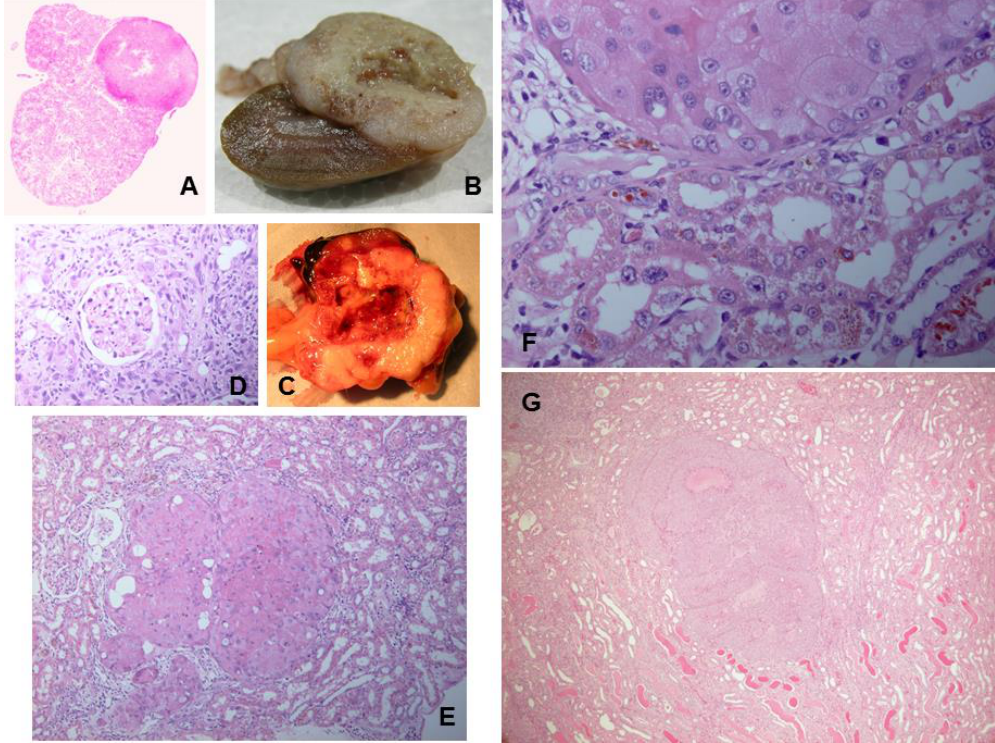
Figure 4. A range of rat macro- and micro-renal tumours from chronic dietary exposure to ochratoxin A. A, Longitudinal section through kidney, and tumour. B, Longitudinal half of kidney and tumour, fixed in formalin. C, Fresh half of kidney with necrotic centre and bounded by traces of original kidney. D, Glomerulus surrounded by tumour infiltrated into surrounding cortex. E, Micro-tumour located at the cortico-medullary junction. F, Junction between micro-carcinoma and kidney parenchyma showing karyocytomegaly in both tissues. G, Micro-carcinoma with small necrotic centre. B and C, Lifetime exposure to ochratoxin A; the rest relate to 10-month